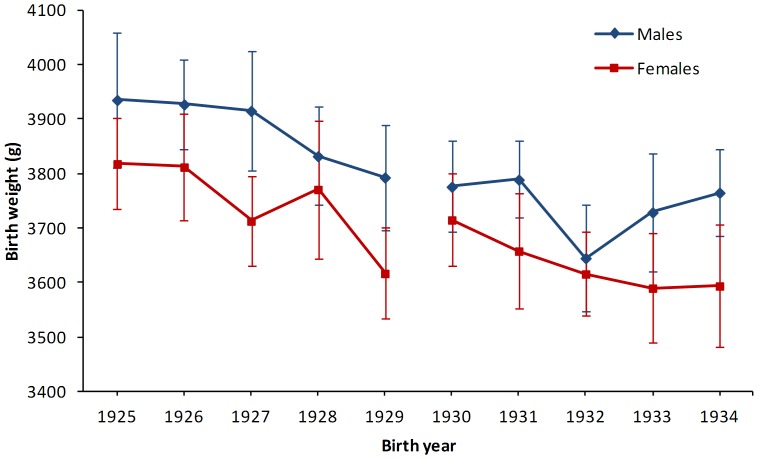
Yearly birth weight for men (diamond) and women (square) born between 1925 and 1934.Footer: Data are shown as means and the bars denote the standard error of the means. Birth weight is further stratified by sex and grouped by birth during pre-Depression (1925–1929) and during the Depression (1930–1934).